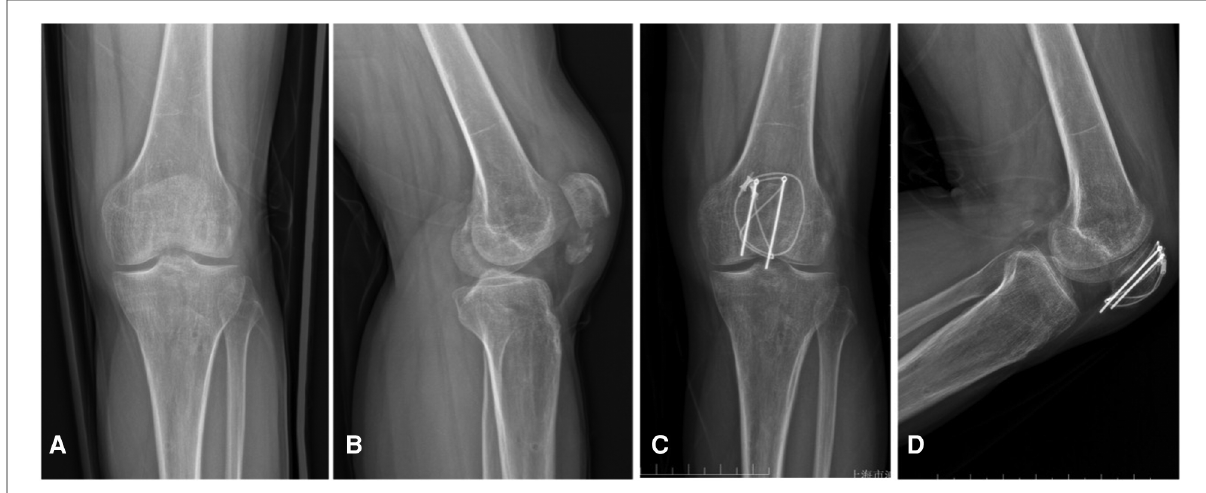
FIGURE 2 Case example of displaced inferior patellar pole fracture (Male, 36 years, left knee) using the ring-pin combined with cable cerclage. Preoperative radiographs in anteroposterior ( A ) and lateral ( B ) views showing a displaced inferior patellar pole fracture. Radiographs in anteroposterior ( C ) and lateral ( D ) views at 3 months follow-up, which show that the fracture was healed and the implants were in position without